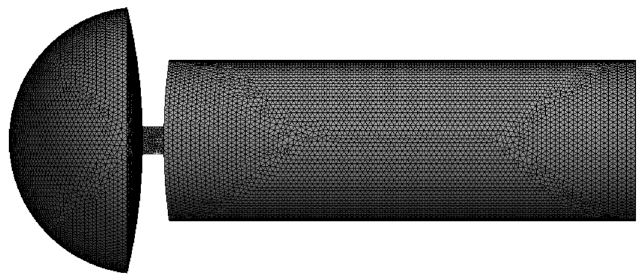
Figure 4. Acoustic grids in the sound source zone.